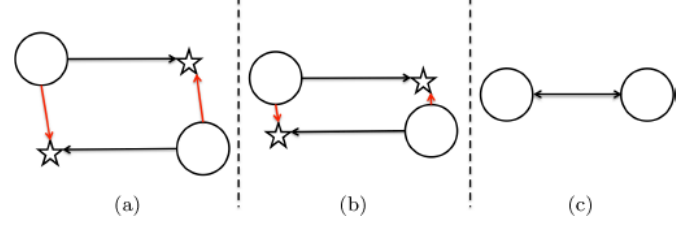
Fig. 1. The process of